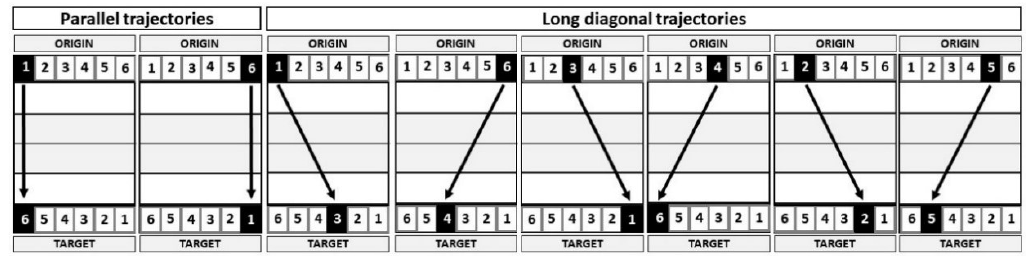
Figure 1. Trajectories proposed in the penalty shooting